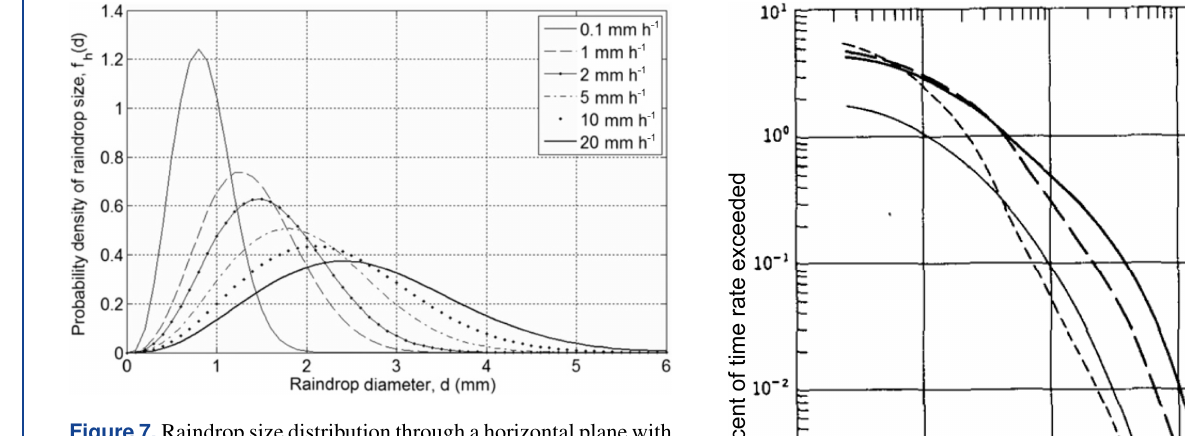
Figure 7. Raindrop size distribution through a horizontal plane with the rain fall intensity as a parameter (from Kubilay et al., 2013, based on Best, 1950).